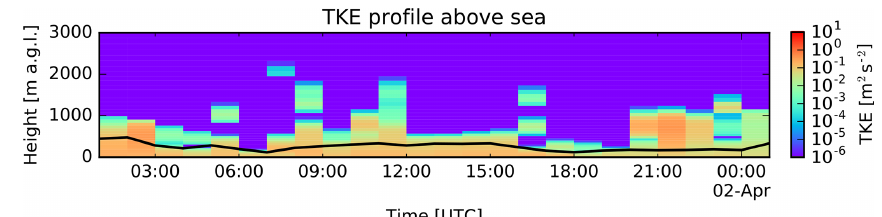
Figure 3. The real TKE profile used in the validation tests above the sea. The black curve corresponds to the PBL height computed by FLEXPART.